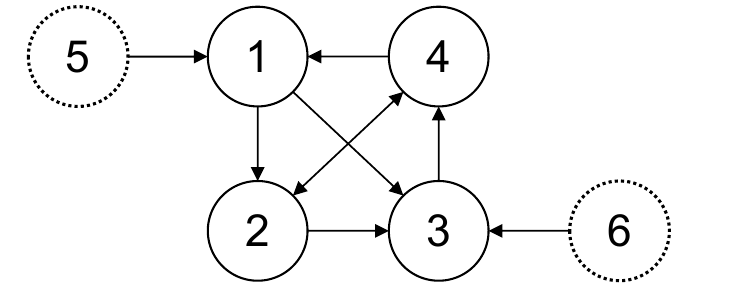
Figure 1. Communication graph.